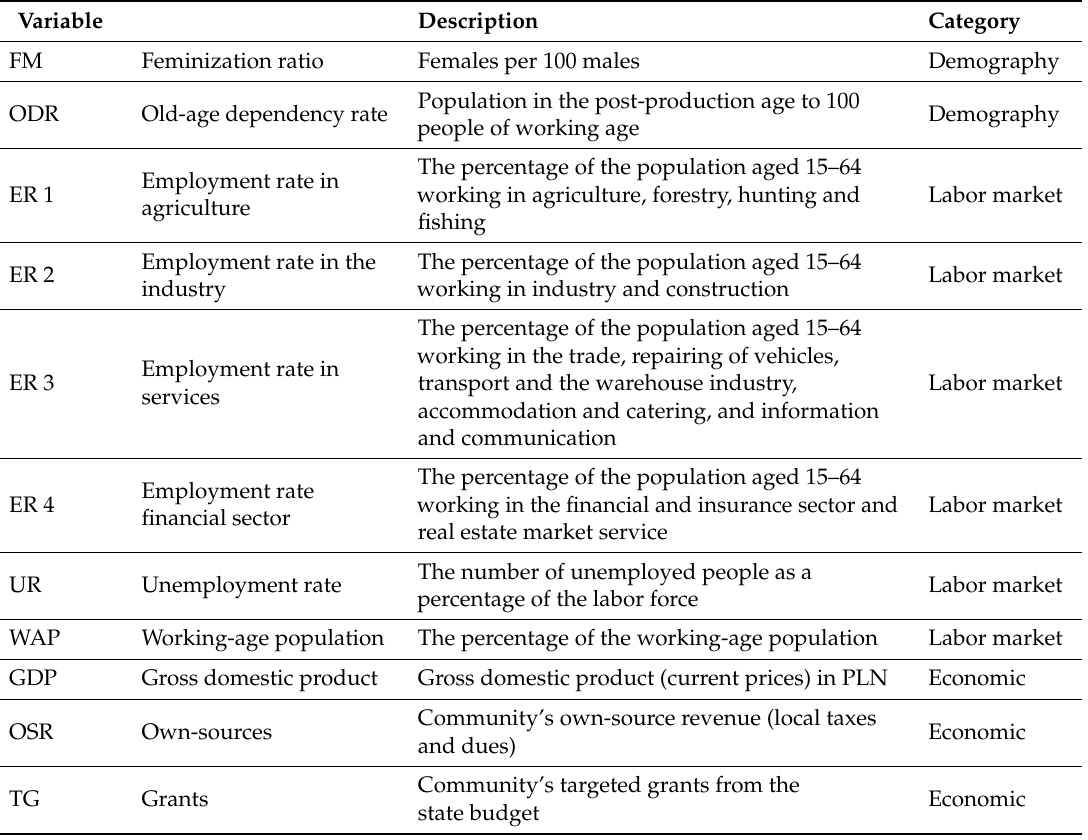
Table 2. Selected socio-economic determinants of health